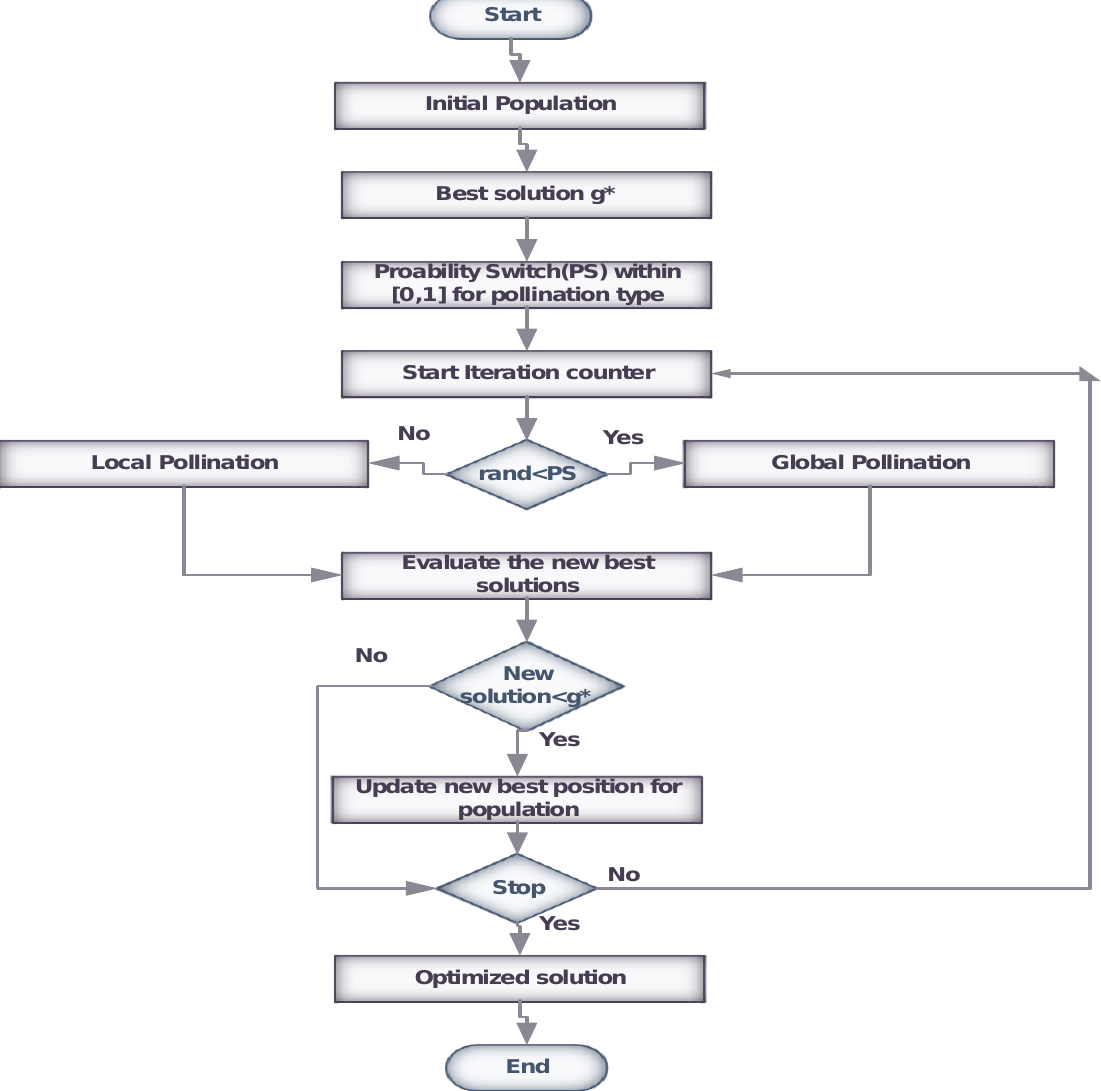
Figure 2. FPA Flow Chart: Where * denotes global best.